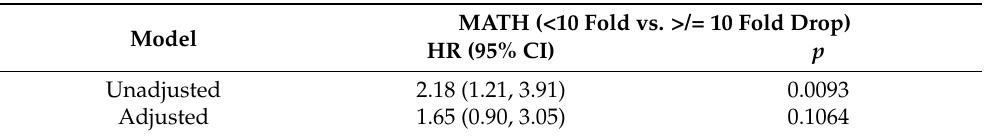
Figure 4. Shorter PFS in patients that did not have a 10-fold decrease. Kaplan–Meier curves showing shorter PFS with a post-induction decrease in MATH from pre-induction not exceeding a 10-fold drop. Table 6. Association between PFS and decrease in MATH in Cox proportional hazard models. Clinical factors for adjustment included treatment arm and liver resection during the first